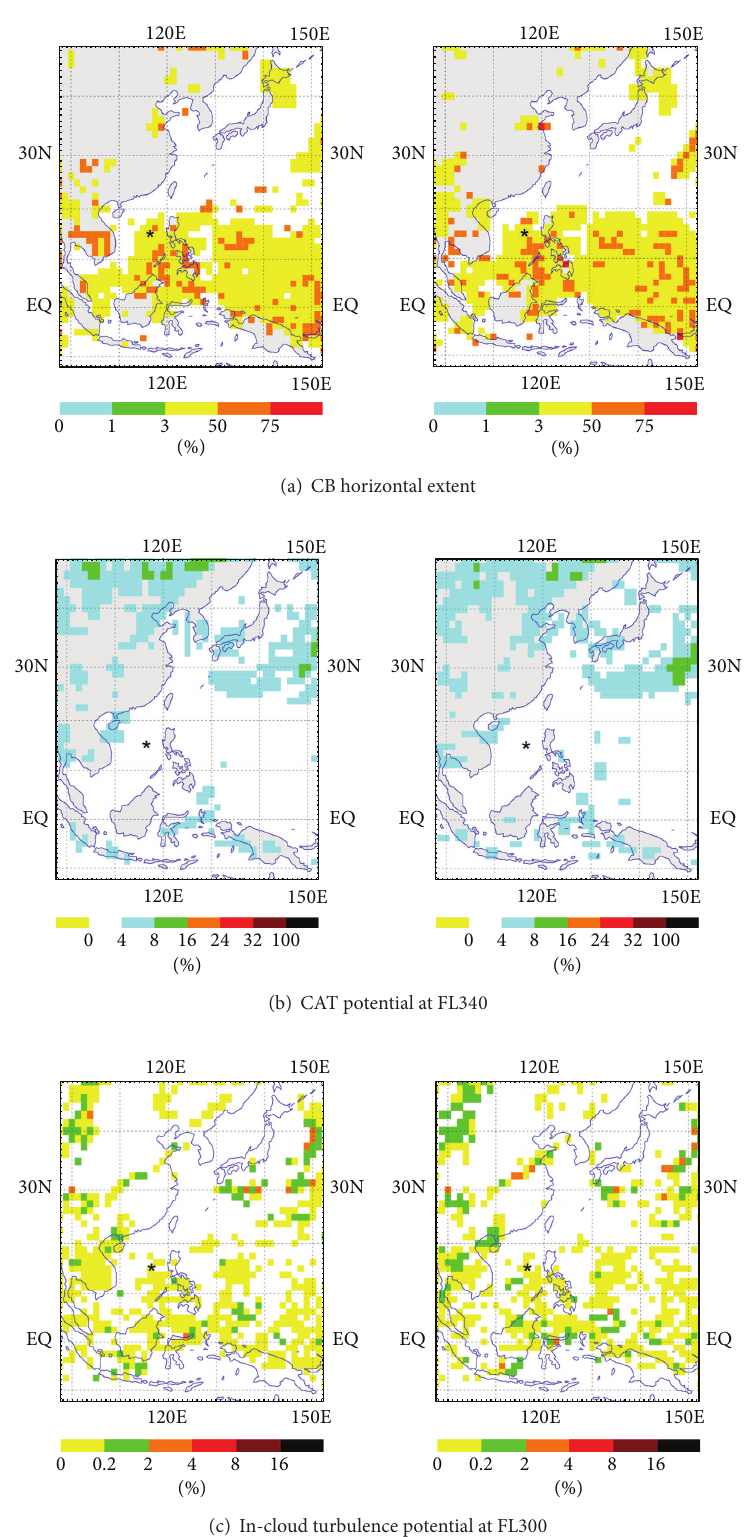
Figure 7: Selected products from WAFC London based on the model run at 12 UTC, 8 August 2013. The forecast times at T+24 are shown on the left hand side and at T+27 on the right hand side. The asterisk shows the location of the turbulence